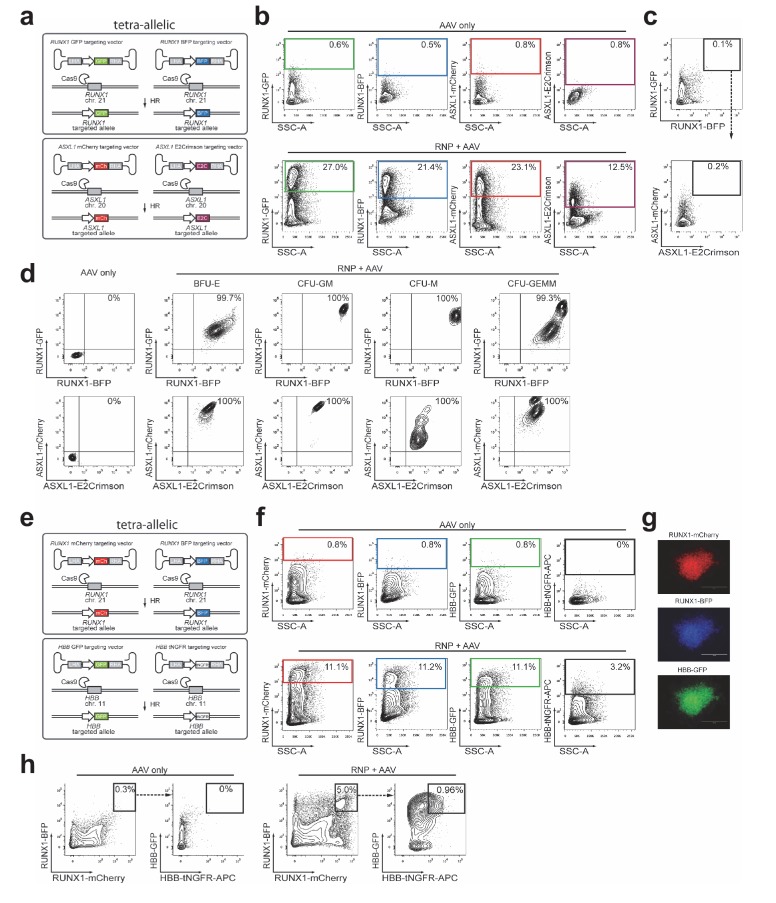
Targeting two genes for biallelic homologous recombination (HR) in primary CD34+ HSPCs.(a) Schematic showing experimental strategy for Figure 4a for targeting both alleles of RUNX1 and ASXL1. (b) FACS plots, gating scheme, and frequencies of HR at each allele for the experiment shown in Figure 4a. (c) FACS plot showing very low frequency of tetra-reporterhigh cells without Cas9. (d) FACS plots of cells from single methylcellulose colonies derived from tetra-reporterhigh cells from Figure 4a. (e) Schematic showing targeting both alleles of RUNX1 and HBB for HR with four distinct reporters. (f) Top, FACS plots of HSPCs transduced with four rAAV6s (no Cas9 RNPs) showing the gating scheme and low episomal reporter expression without a nuclease. Bottom, HSPCs were electroporated with RNPs targeting HBB and RUNX1 and then transduced with four rAAV6s. FACS plots from day four post electroporation show MFI shift for each reporter alone. HBB-tNGFR rAAV6 has reproducibly shown lower episomal expression than all other rAAV6 we have used. (g) Images from fluorescence microscopy showing an mCherry/BFP/GFP positive CFU-GM clone that has undergone tetra-allelic HR. The colony was not stained for HBB-tNGFR. (h) Left, FACS plots show very low frequency of tetra-reporterhigh cells without Cas9. Right, Nuclease addition increases the frequency of bi and tetra-reporterhigh HSPCs.